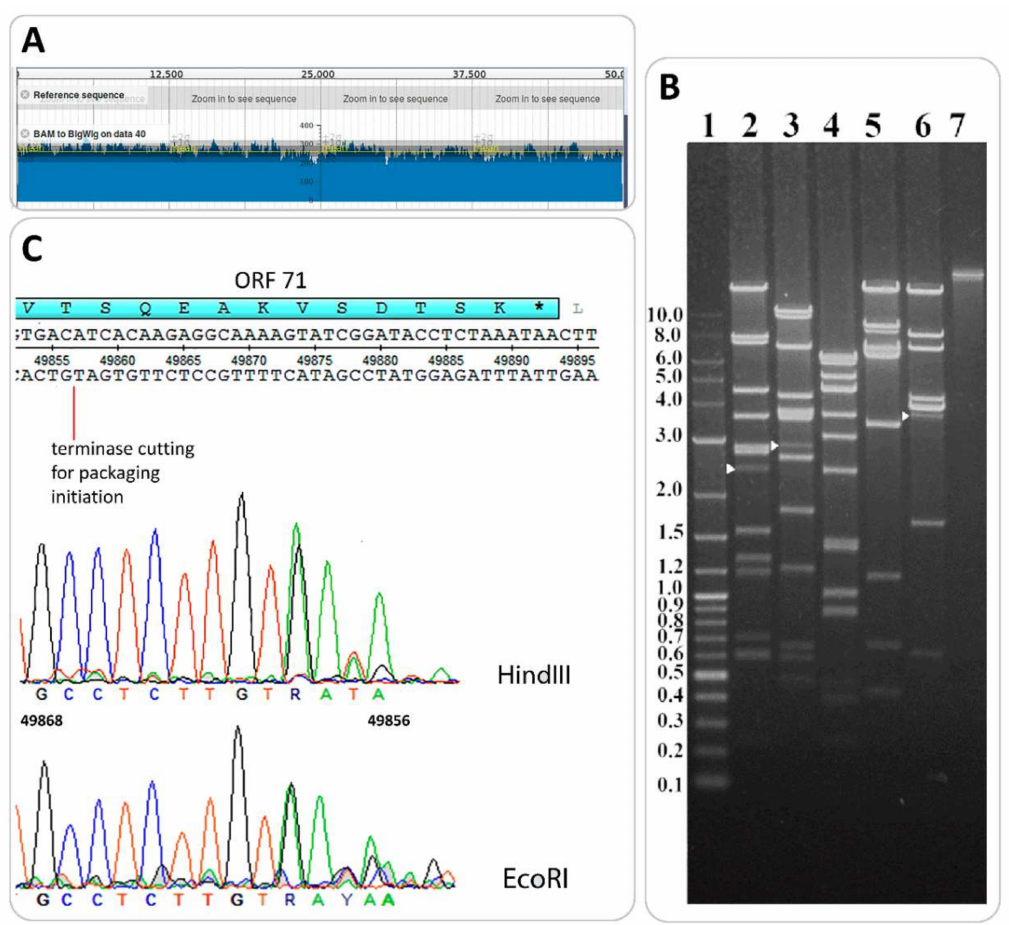
Figure 7. Determination of packaging strategy. ( A ). Genome coverage plot was obtained with PAUSE3 [10]. No peaks deviate significantly from the mean (yellow line). ( B ). Restriction analysis of B83 DNA with enzymes HindIII (lane 2), EcoRI (lane 3), NsiI (lane 4), XbaI (lane 5), and BsrGI (lane 6). Molecular weight markers and intact DNA are in lanes 1 and 7, respectively. White arrows indicate pac -fragments. ( C ). Location of terminase-generated cut in the B83 genome. Terminal regions of sequencing reads for HindIII-generated and EcoRI-generated pac -fragments are displayed in sequencing